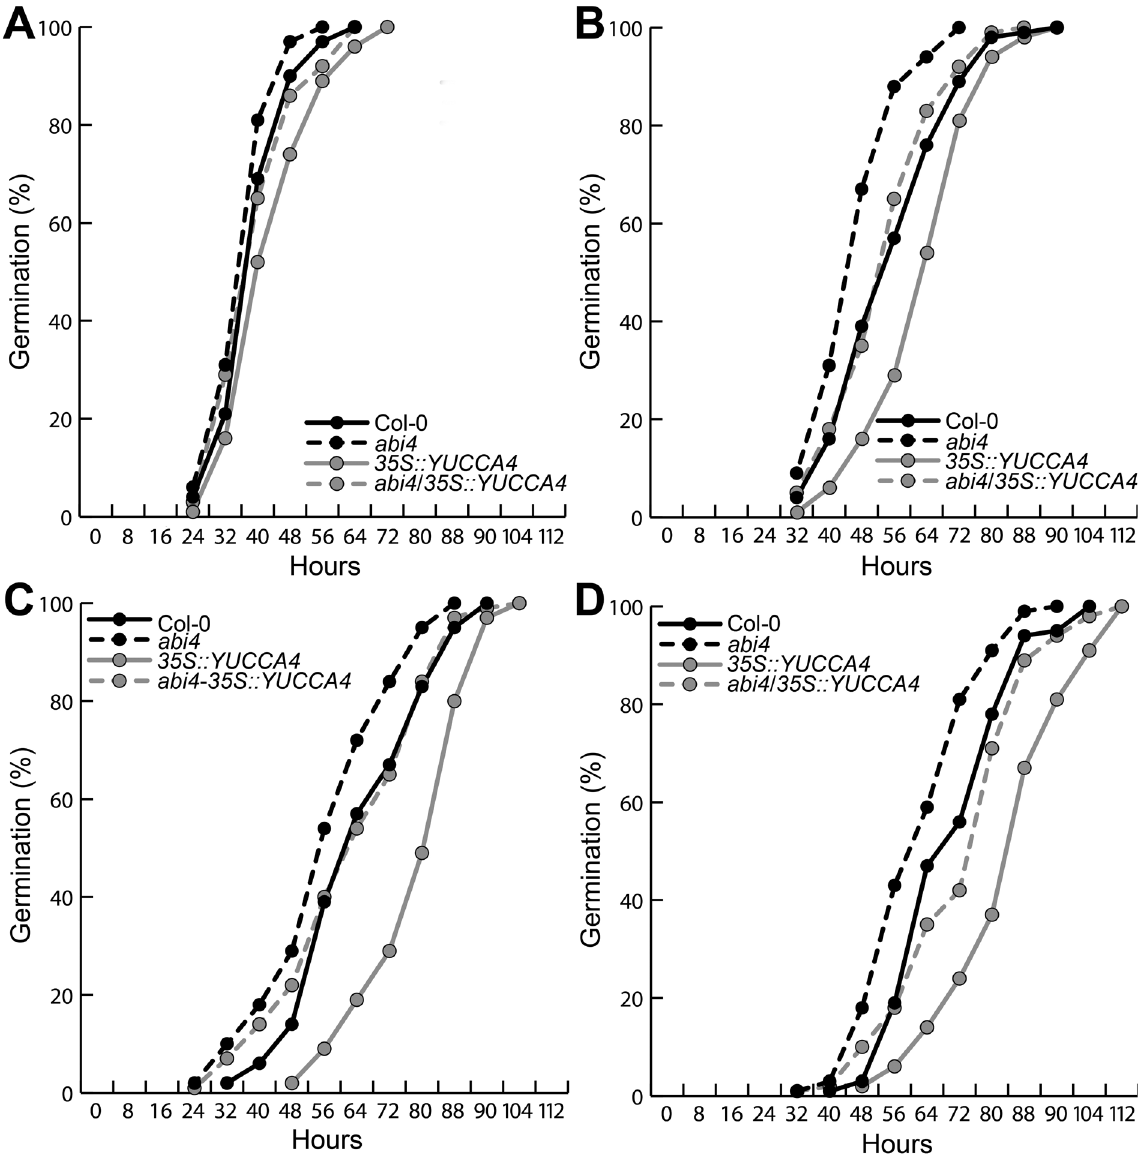
Figure9 -EffectsofABAongermination. Arabidopsis seedsofCol-0, abi4 , 35S::YUC4 and abi4 / 35S::YUC4 weresownonMSplatescontainingdiffer- ent ABA concentrations: (A) Mock, (B) 0.5 (cid:2) M, (C) 1 (cid:2) M and (D) 2 (cid:2) M ABA. Radicle protrusion of 100 seedlings of each line was registered every 8 hours. Note the contrasting effects of the ABA over 35S::YUCCA4 and abi4 seedlings. The experiment was repeated three times with similar